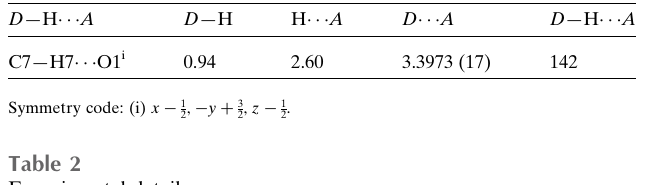
Table 1 Hydrogen-bond geometry (A˚ , (cid:2) ).